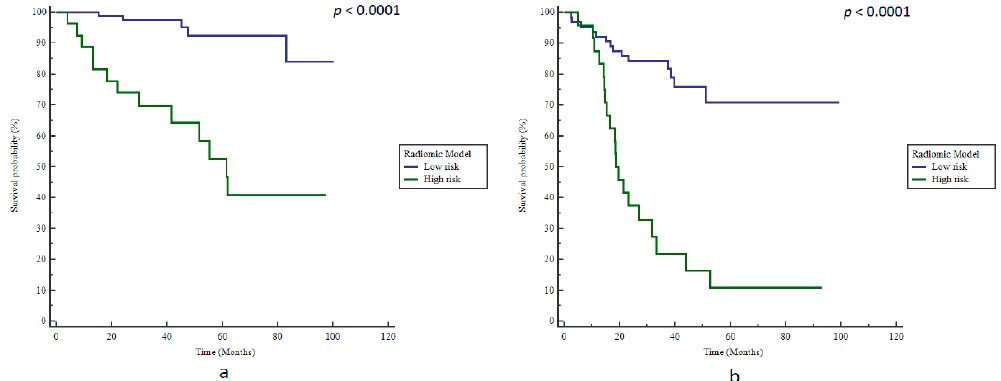
Figure 4. Kaplan–Meier estimates of biochemical relapse-free survival using the radiomics model in ( a ) training and ( b ) testing cohorts.